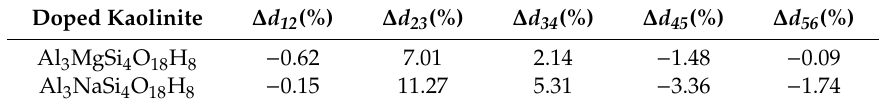
Table 3. Relative to the undoped kaolinite (Al 4 Si 4 O 18 H 8 ), the statistics of atomic layer change rate of